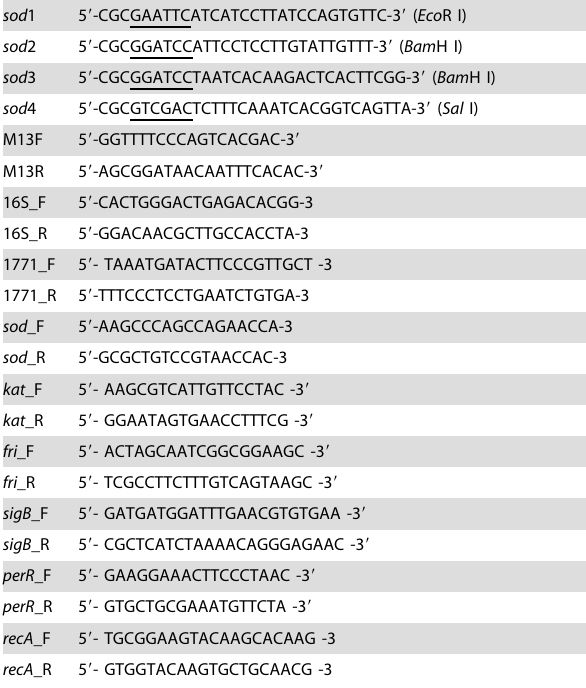
Name Oligonucleotides (Restriction enzyme sites are underlined) sod